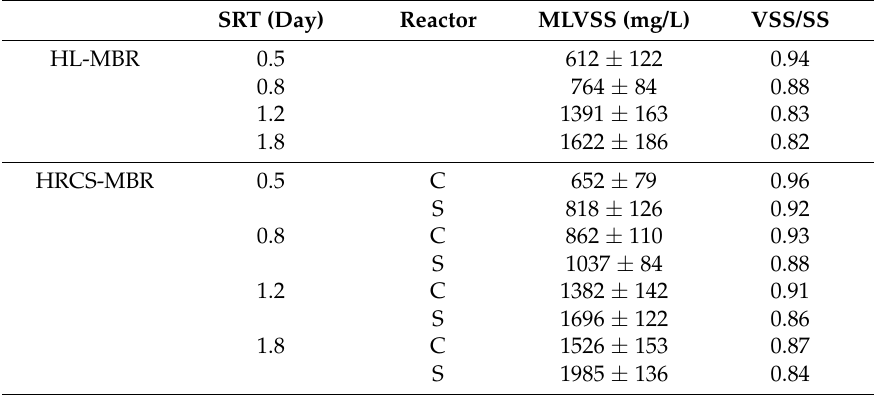
Table 2. Sludge characteristics in both MBRs at different solids retention times